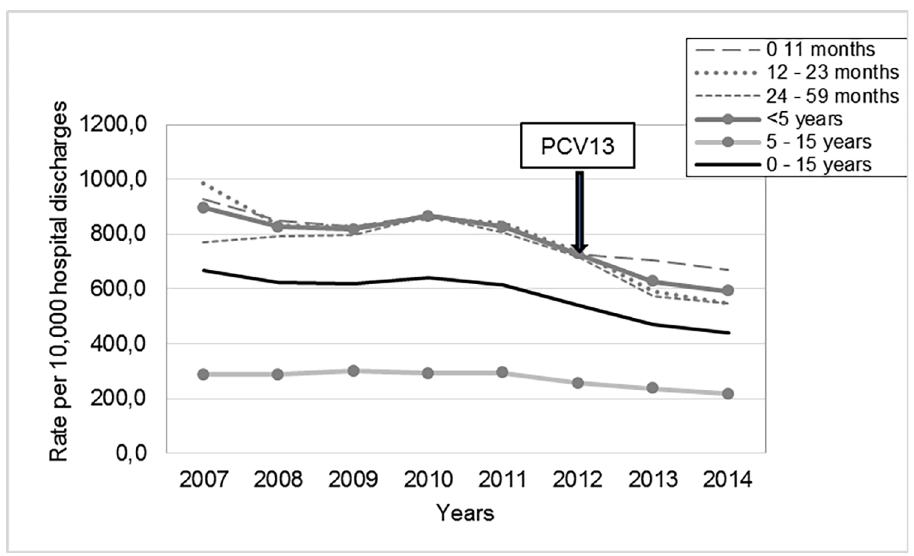
Fig 1. Discharge rate of consolidated pneumonia by age group during 2007–2014.